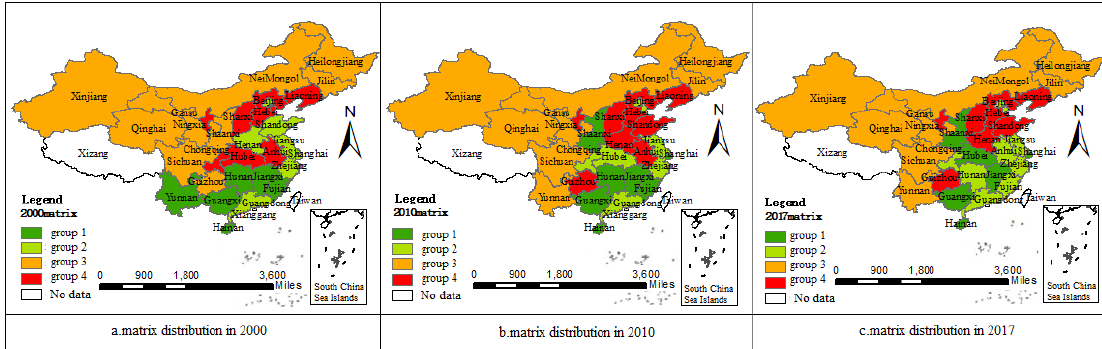
Figure 7. Spatial pattern of evaluation matrix in 2000, 2010 and 2017.